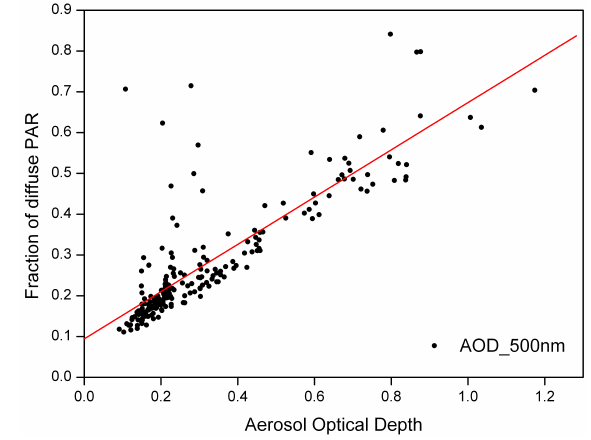
Fig. 10. Relationship between Aerosol optical depth (AOD) and fraction of diffuse PAR ( D f ) for linear fit ( n = 209, r 2 = 0 . 69, p < 0 .